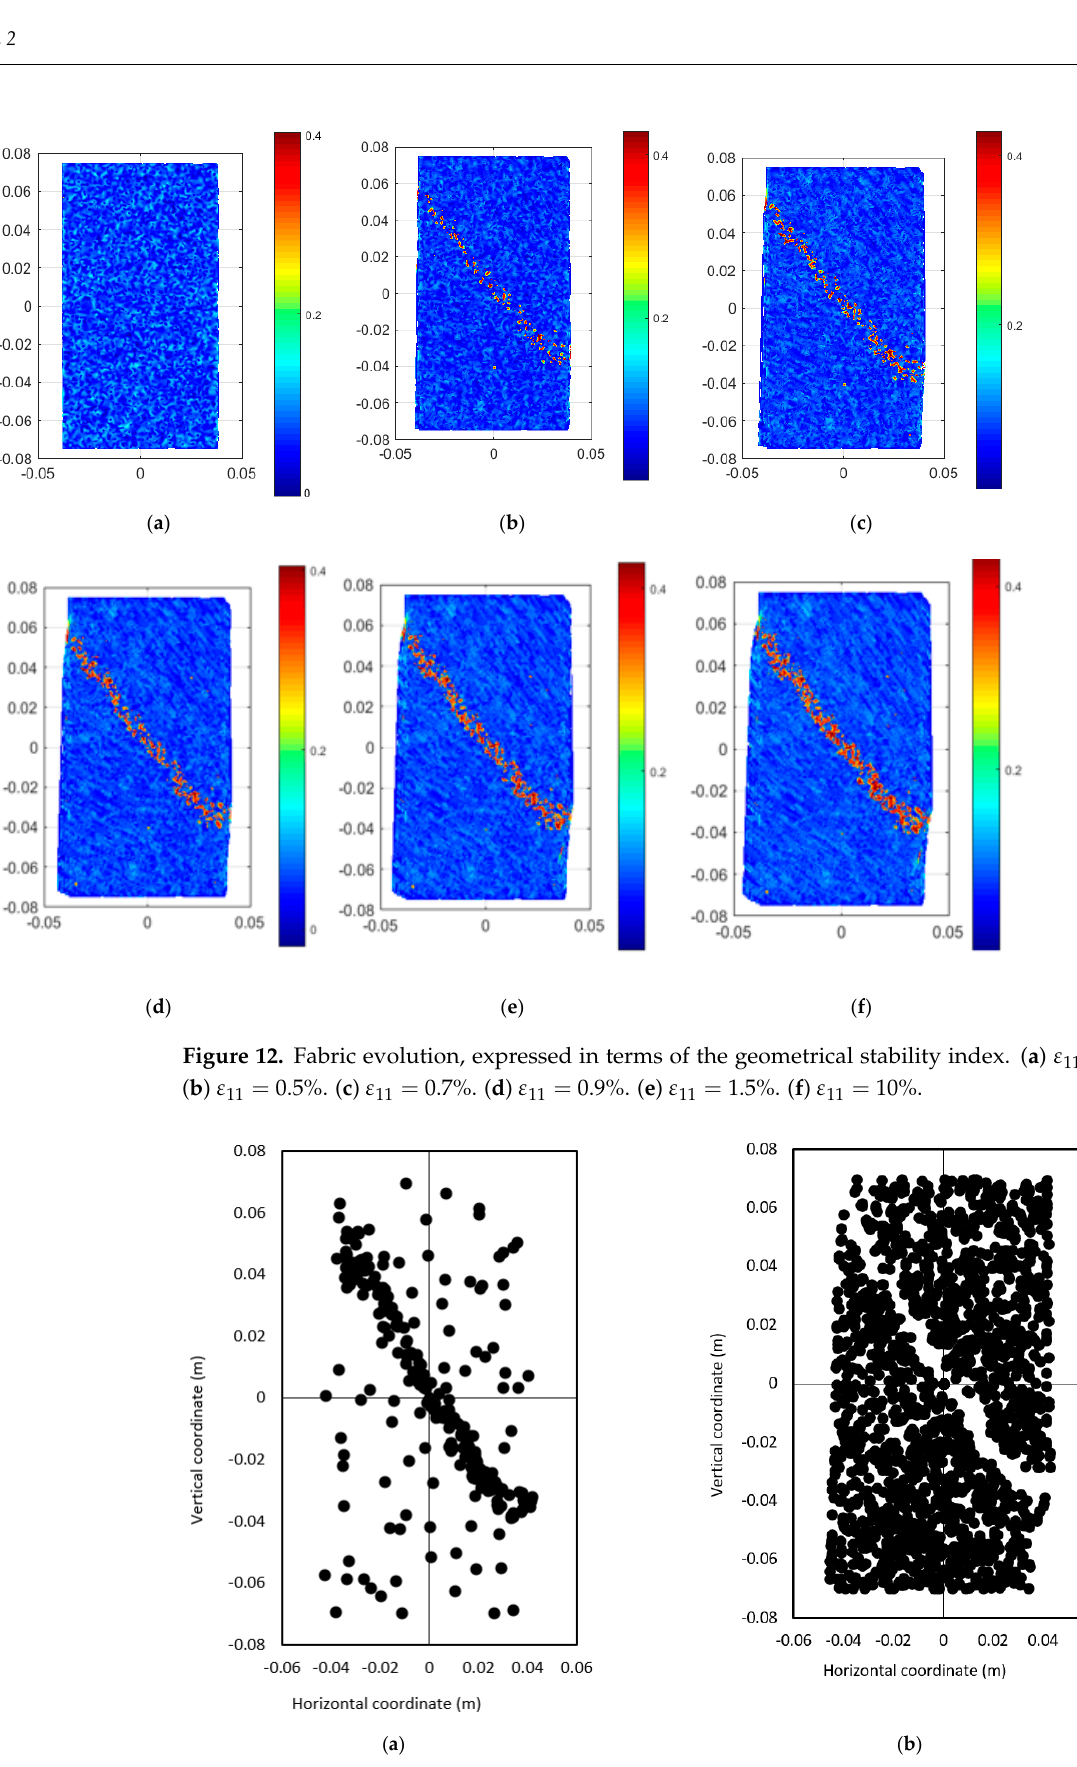
Figure 13. Distribution of particles with ( a ) two contacts ( b ) three and more contacts. ( a ) Those particles having two contacts at 𝜀 (cid:2869)(cid:2869) = 1.5%. ( b ) Those particles having at least three. The variation of average geometric stability index with axial strain is shown in Figure 14. The trend of this average quantity is in good agreement with the trend of stress ratio and fabric anisotropy with axial strain (Figure 9). The graph also shows that up to peak stress ratio, the geometric stability index increases from its initial stable contact arrange- ment and then reduces to a constant value post peak. This is consistent with the distribu- tion of the geometric stability indices in Figures 12f which shows a pattern similar to that at peak stress (Figure 12e).